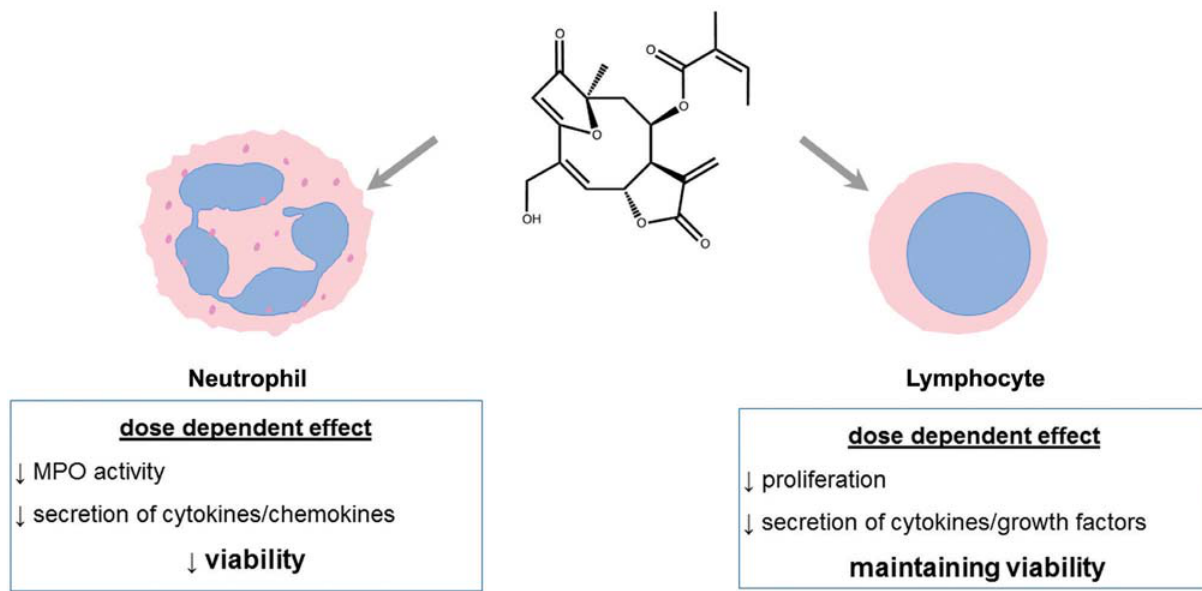
Figure 3- Graphical abstract showing effects of Budlein A on human neutrophils and lymphocytes cytokines may allow a local inflammation to (cid:69)(cid:72)(cid:70)(cid:82)(cid:80)(cid:72)(cid:3) (cid:68)(cid:81)(cid:3) (cid:88)(cid:81)(cid:70)(cid:82)(cid:81)(cid:87)(cid:85)(cid:82)(cid:79)(cid:79)(cid:72)(cid:71)(cid:3) (cid:86)(cid:92)(cid:86)(cid:87)(cid:72)(cid:80)(cid:76)(cid:70)(cid:3) (cid:76)(cid:81)(cid:192)(cid:68)(cid:80)(cid:80)(cid:68)(cid:87)(cid:82)(cid:85)(cid:92)(cid:3) response 8,20,21